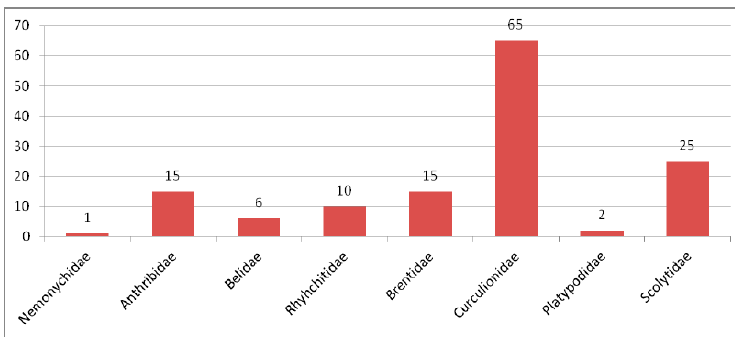
Figure 13. Composition of species of Curculionoidea in the Baltic amber.